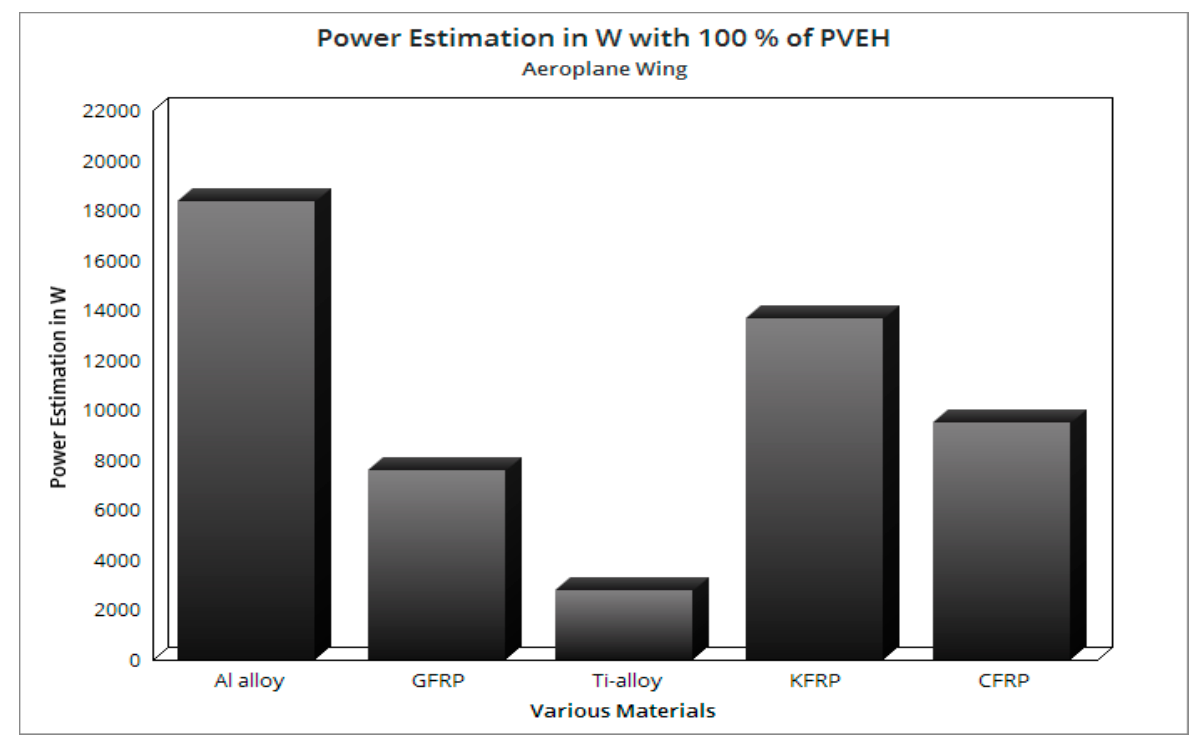
Figure 29. A typical view of an airplane wing with piezoelectric patches.